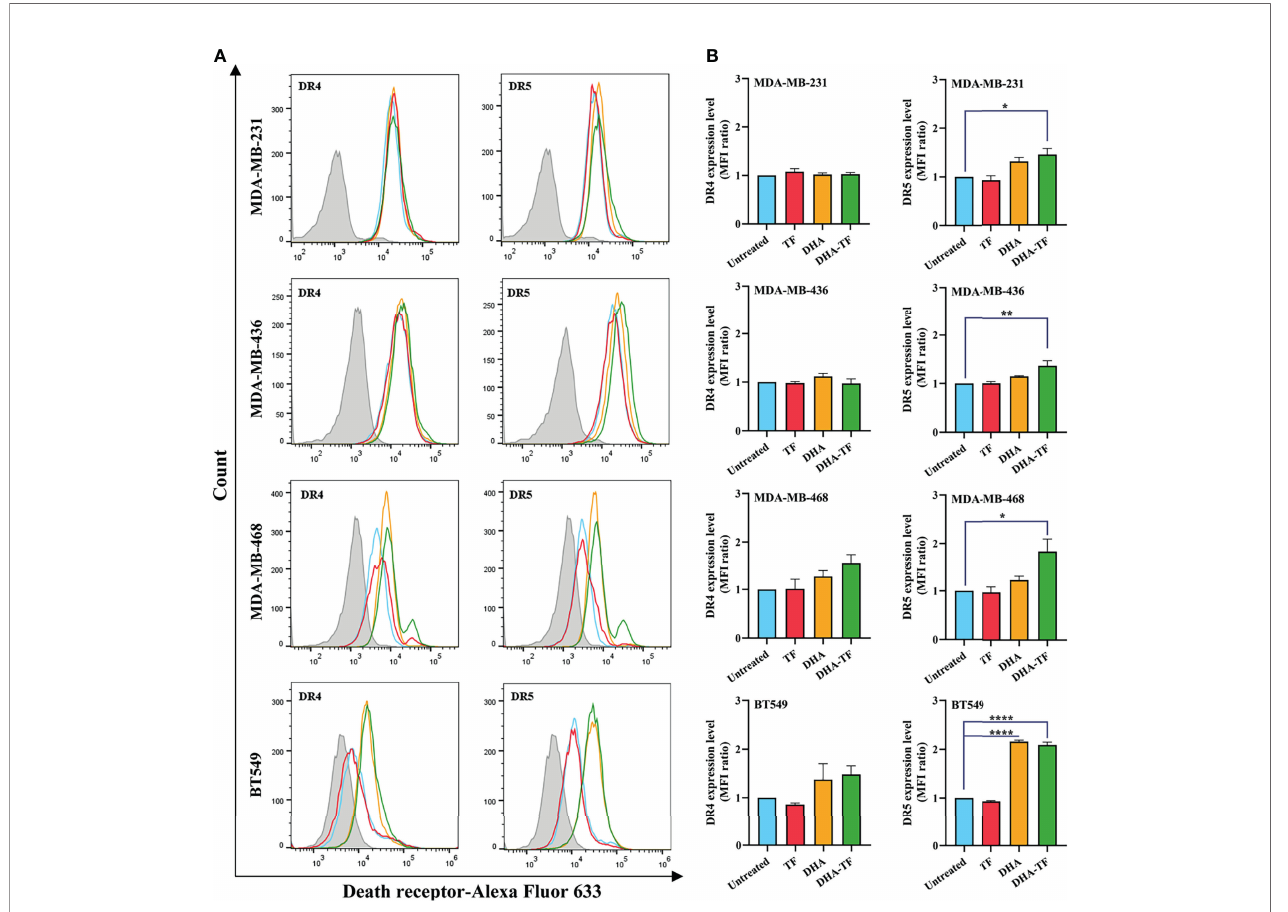
FIGURE 7 | DHA-TF signi fi cantly upregulates DR5 expression on the surface of TNBC cells. (A) TF, DHA, or DHA-TF were added to MDA-MB-231 (15 µM), MDA-MB-436 (15 µM), MBA-MD-468 (5 µM), and BT549 (5 µM) for 24 h. The histograms of death receptors expression were analyzed using FlowJo v10 software. (B) The mean fl uorescence intensity (MFI) ratio relative to unstained cells ( fi lled grey peaks) is shown in bar graphs. Data shown are mean ± SEM from three independent experiments. *0.01 < p ≤ 0.05, **0.001 < p ≤ 0.01, ****p ≤